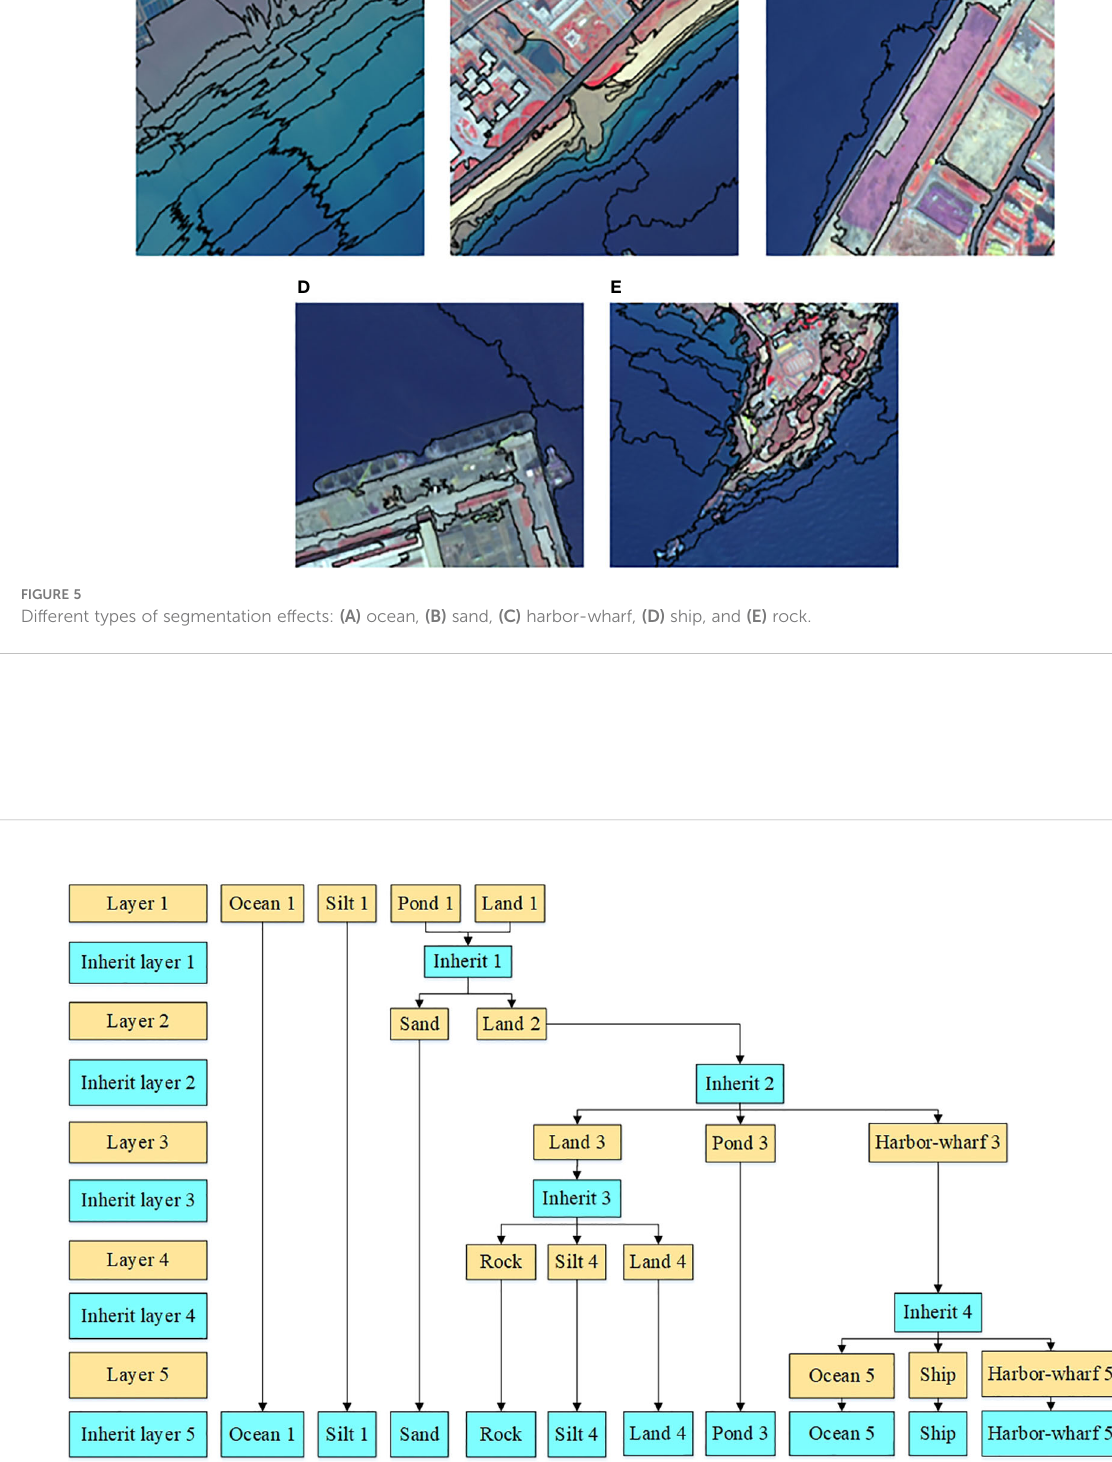
FIGURE 6 Coastline classi fi cation